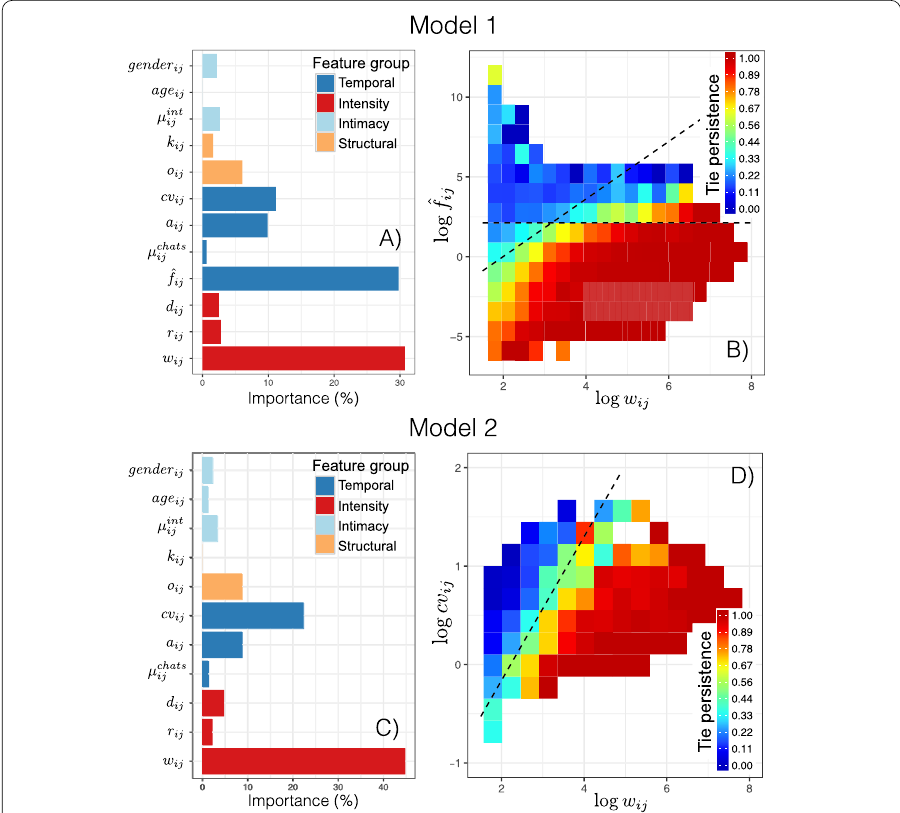
Figure 3 Feature importance in tie persistence. (A) Importance of the variables in the full models in Table 2. Importance is measured as the normalized % of the t-statistics for each model parameter. (B) Density plot of the average persistence of ties as a function of the two most important variables in (A) , namely, normalized freshness and total number of calls for model 1 and coefficient of variation and total number of calls for model 2. The dashed line shows the solutions of equation (cid:5) = 1/2 for the simplified models in Table 2.